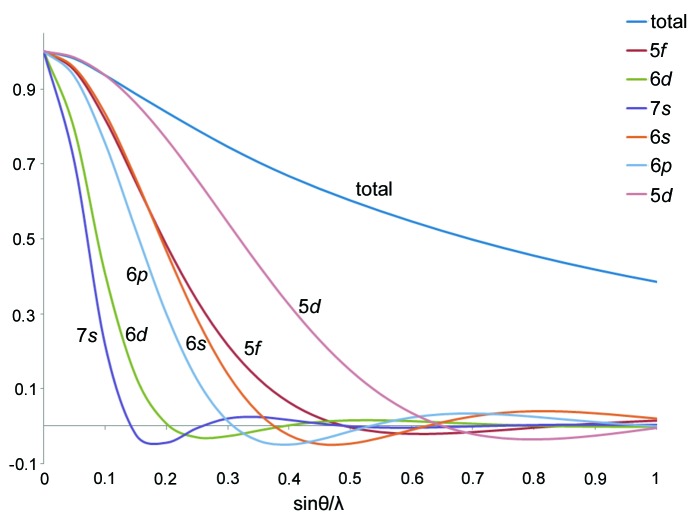
Scattering factors (normalized to one electron) for the uranium atom and selected subshells plotted against resolution up to sin(θ)/λ = 1 Å−1.